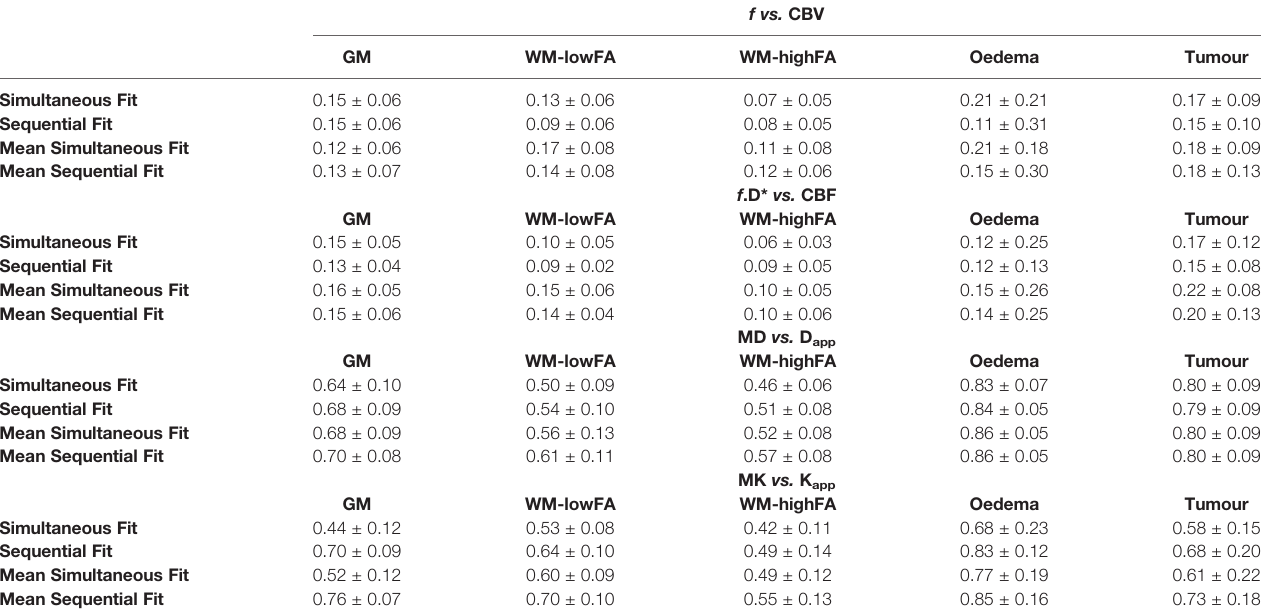
TABLE 3 | Spearman r correlation